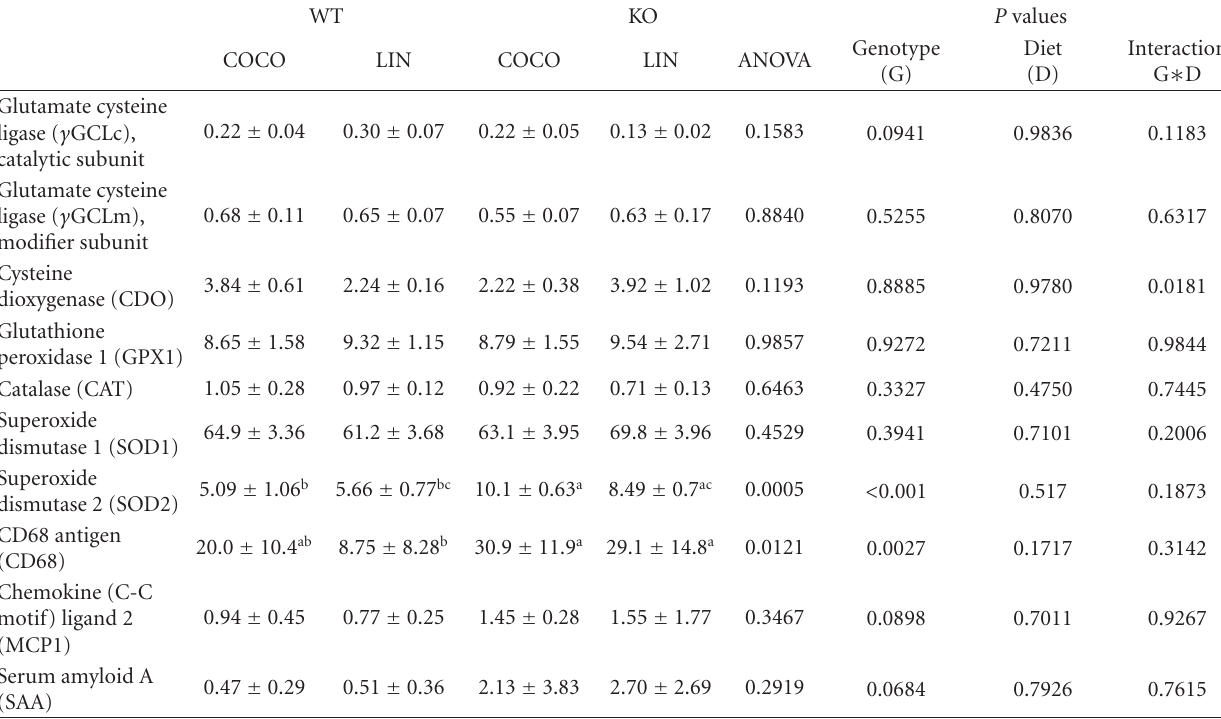
Table 4: Hepatic mRNA levels of cysteine and glutathione metabolism key genes, and of inflammatory markers, in WT and PPAR α -null (KO) mice fed diets containing either saturated FA (COCO diet) or ALA (LIN diet) for 8 weeks (arbitrary units). WT